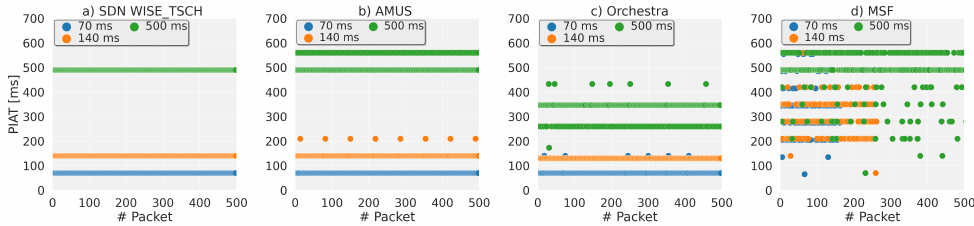
Figure 6. Packet Inter-Arrival Time for each Scheduling protocol with different Packet Period.